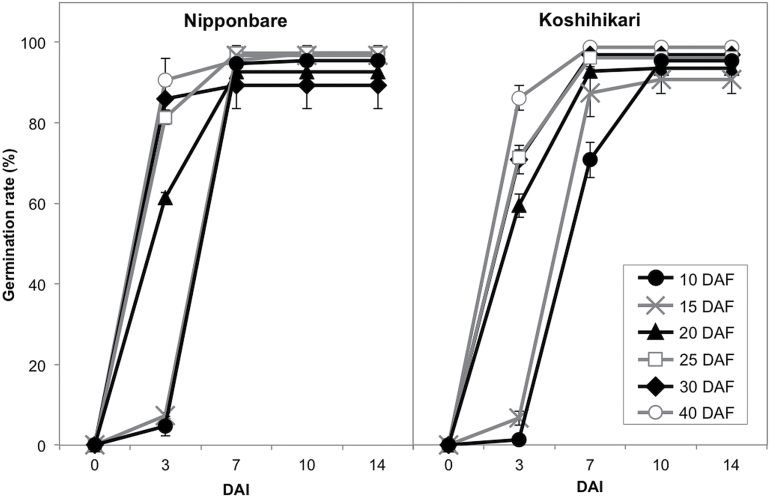
Germination rates of 10 to 40 DAF embryos. Germination vigor of developing embryos of Nipponbare and Koshihikari was evaluated at 0, 3, 7, 10 and 14 DAI. The germination rate values are presented as the means ±SE of three replicates.